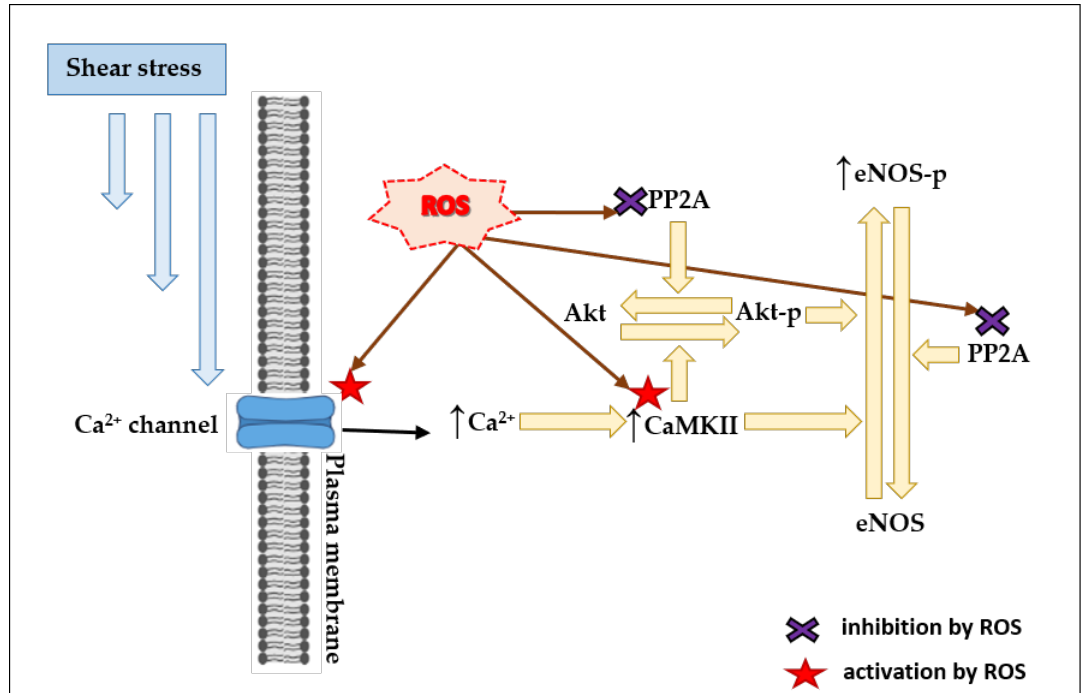
Figure 4. Scheme illustrating the potential involvement of ROS into flow-induced CaMKII-mediated eNOS activation.